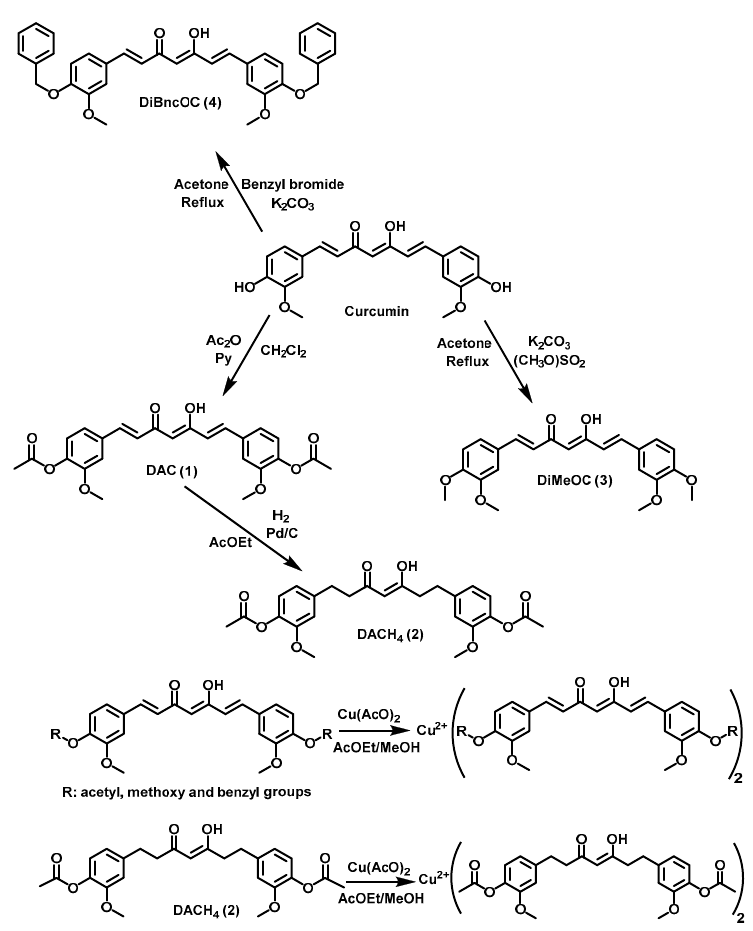
Scheme 1. Synthetic route of curcuminoids and their